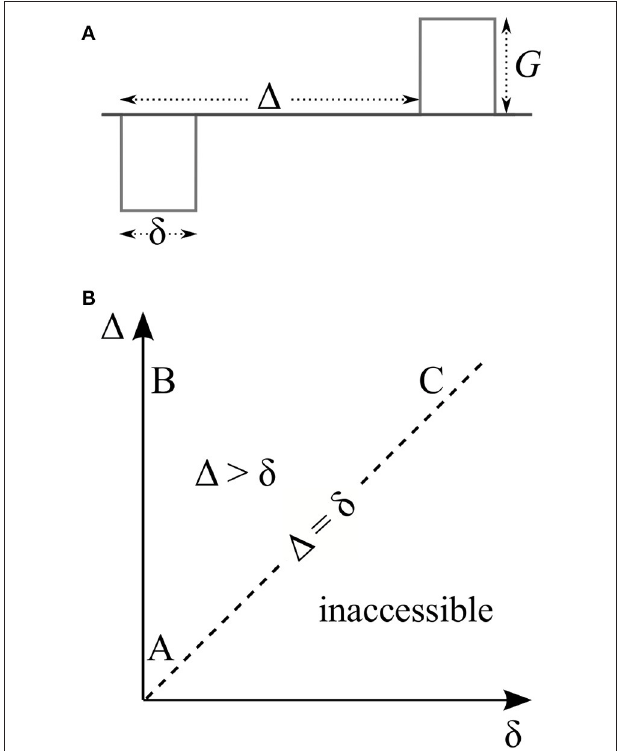
FIGURE 1 | (A) Stejskal and Tanner’s pulsed field gradient experiment features a pair of rectangular gradient pulses of duration δ whose leading edges are separated by 1 . (B) The timing parameters of this experiment lie on or above the dashed line since the separation of the two pulses ( 1 ) has to be at least as long as the duration of each of them ( δ ). Thus, the experiment has three distinct regimes (labeled A, B, and C) based on whether these timing parameters are short or long. These are the three regimes that exhibit all interesting features of the signal. The same features are expected to be observed to various degrees in the intermediate region between these three